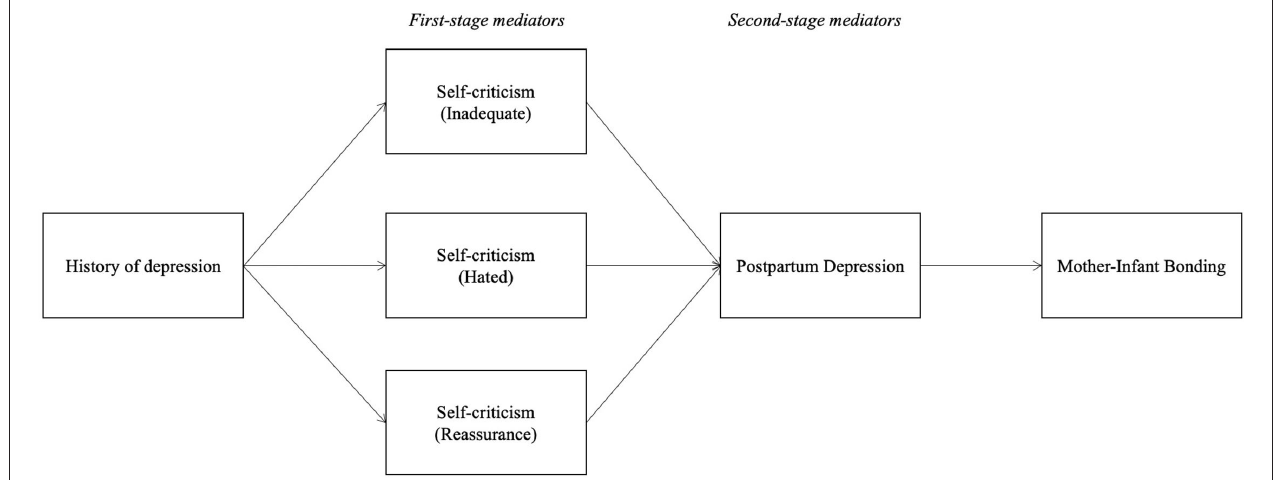
FIGURE 1 | Conceptual mediation model for the presumed influence of history of depression symptoms on mother–infant bonding, through self-criticism and PPD symptoms.